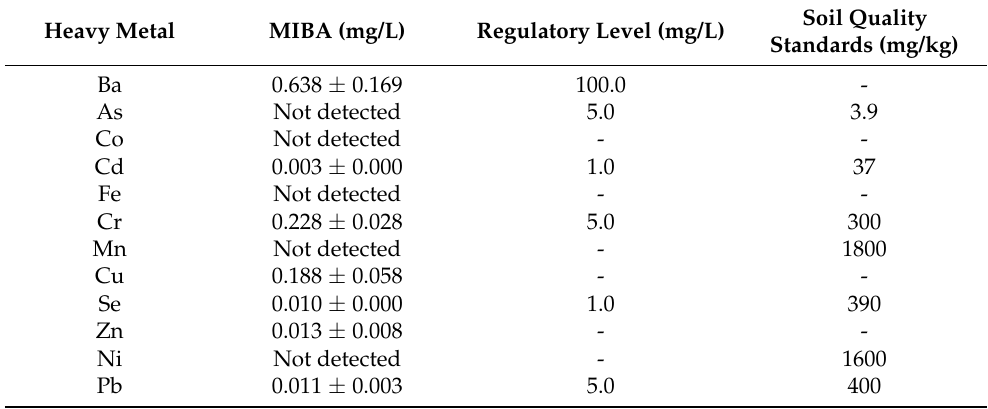
Table 3. Leaching of heavy metals from MIBA.